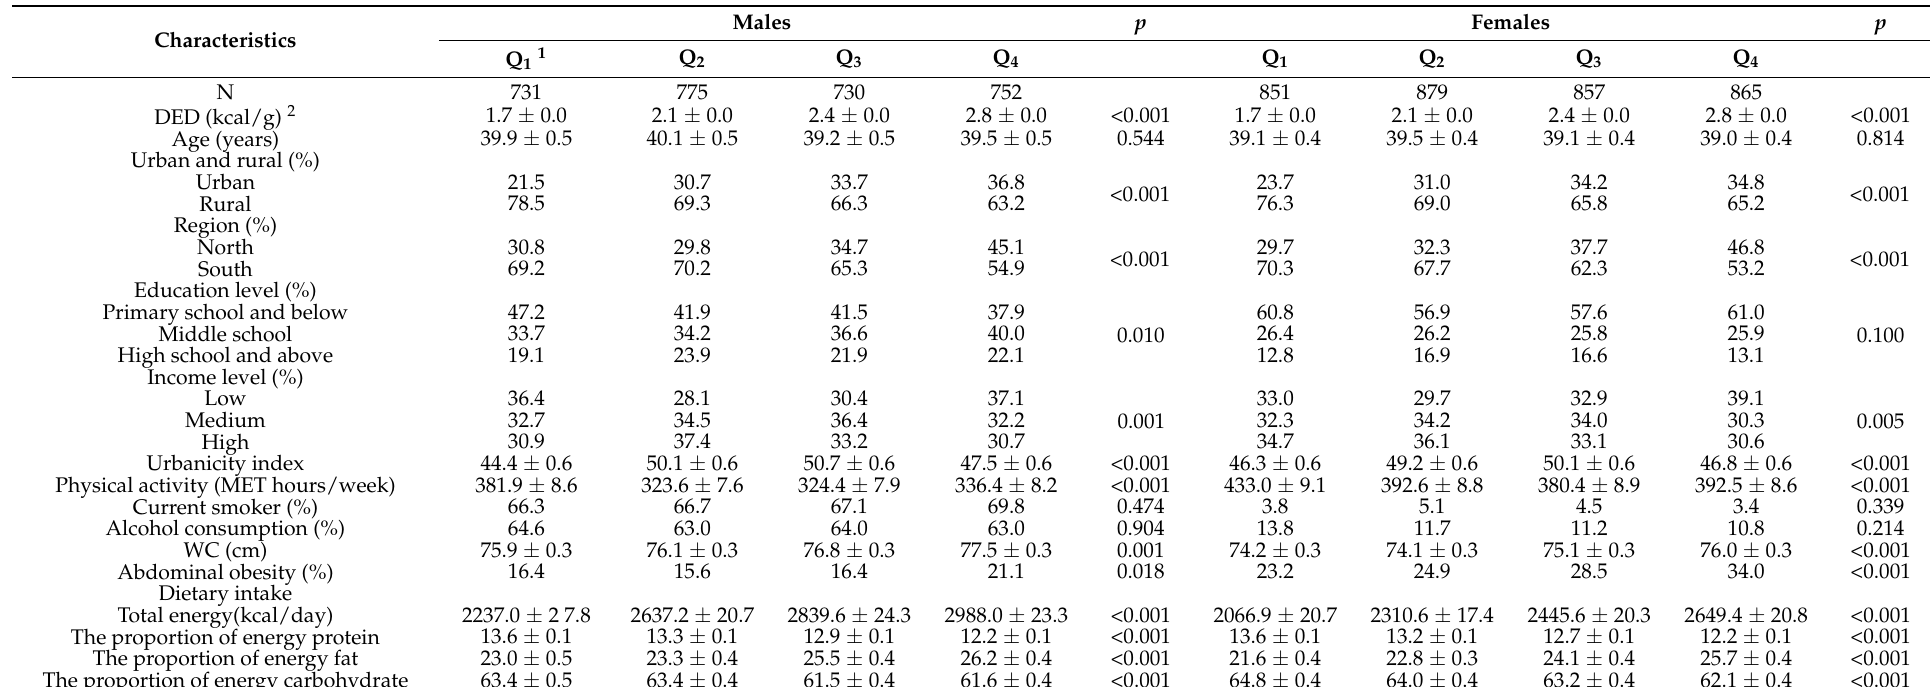
Table 1. Baseline characteristics of participants by quartiles of DED in males and